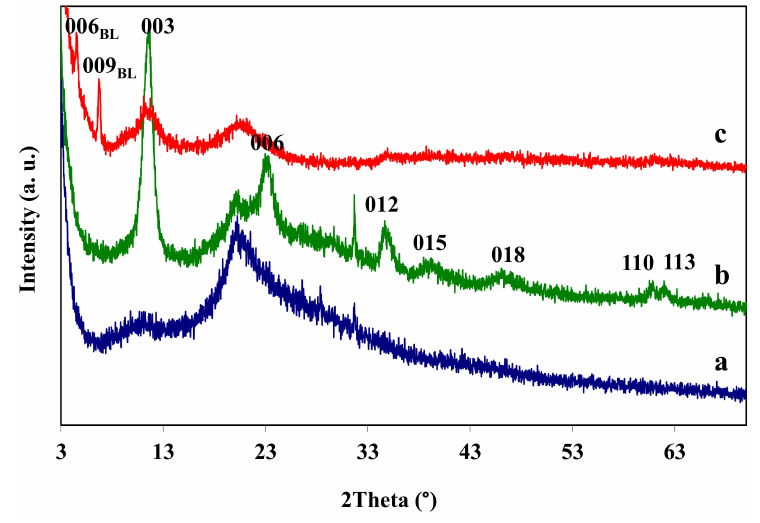
Figure 9. XRD patterns of C ( a ), C-LDH-IBU ( b ) and C-LDH-BLE ( c